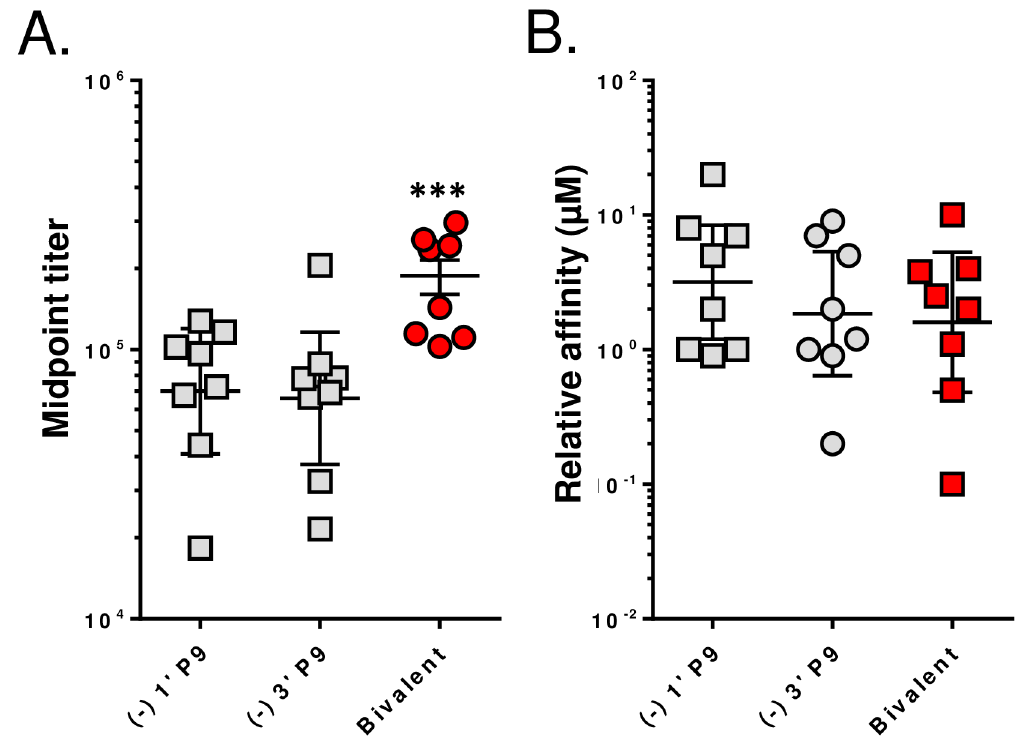
Fig 7. A bivalent nicotine vaccine stimulates an additive increasein antibody titers and equivalent avidities compared to dose-matched monovalent vaccines. Serum was collected56 days after priming from mice immunized with: (1) 10 µ g (-) 1’ P9, (2) 10 µ g (-) 3’ P9 or (3) 5 µ g (-) 1’ P9 + 5 µ g (-) 3’ P9. Sera titers (A) and affinities (B) were assayed by ELISA using plates coated with a 50/50 mixture of (-) 1’ BSA and (-) 3’ BSA. Comparisons betweengroupswere conductedby one-wayANOVA. *** p <